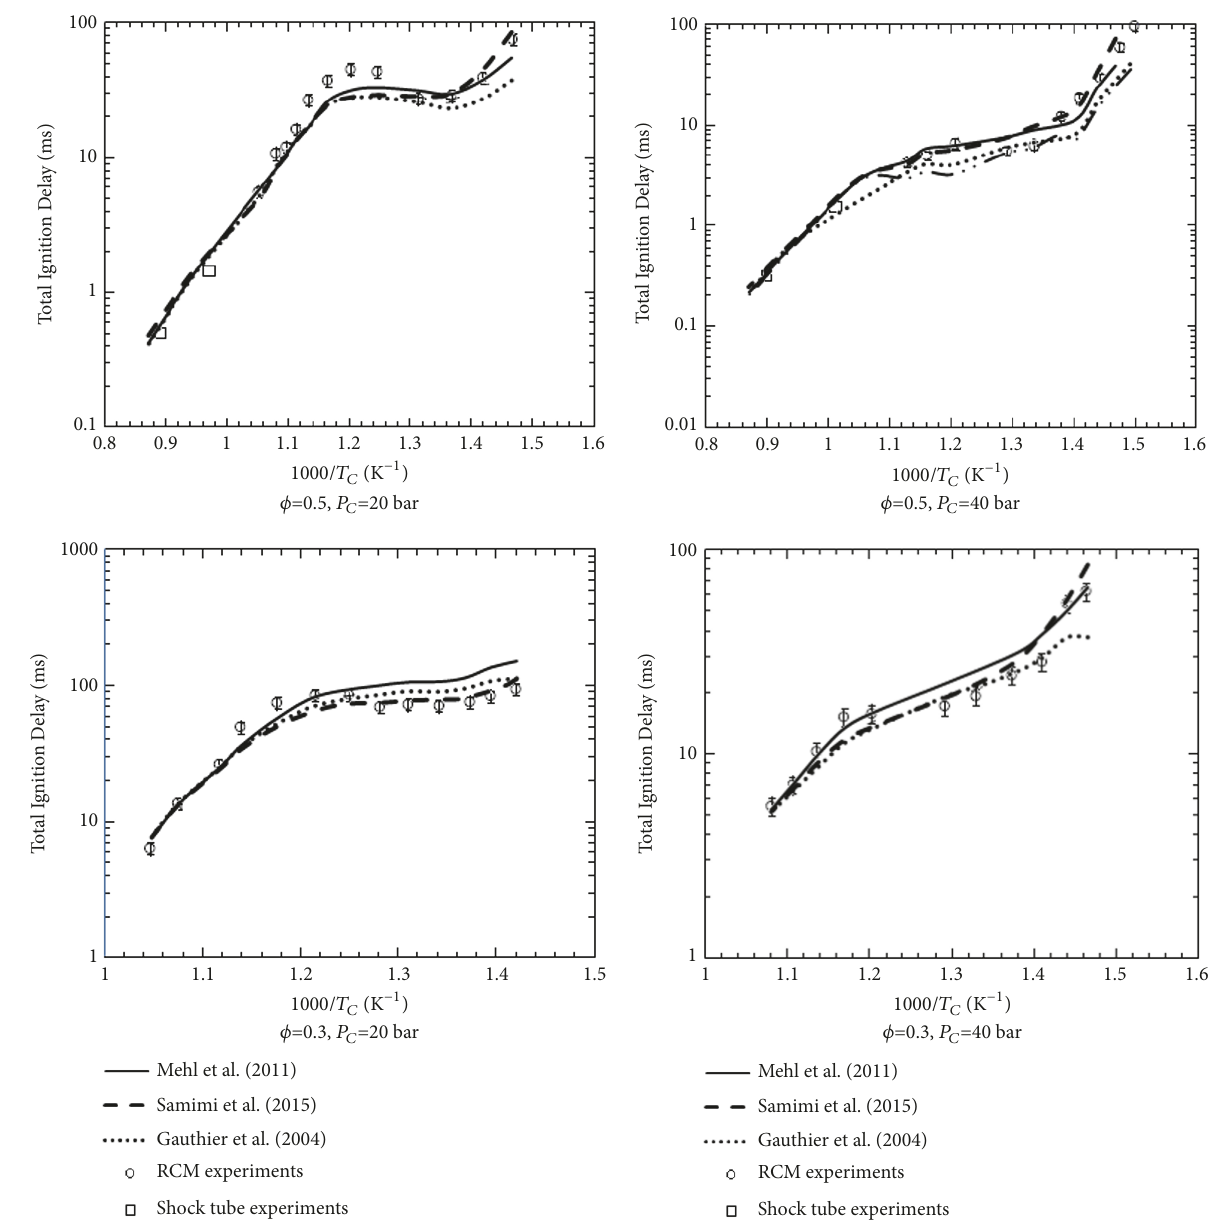
Figure 17: Comparison of RD387 experimental and simulated surrogate total ignition delay times. Experimental data is from Kukkadapu et al. [23] and Gauthier et al. [10]. Surrogate simulations were carried out using Mehl et al. [13], Gauither et al. [10], and Samimi Abianeh et al. [19] surrogates using the mechanism of Samimi Abianeh et al. [19]. Measured shock tube data are shown using ◻ at two approximate temperatures of 1000 K and 1100